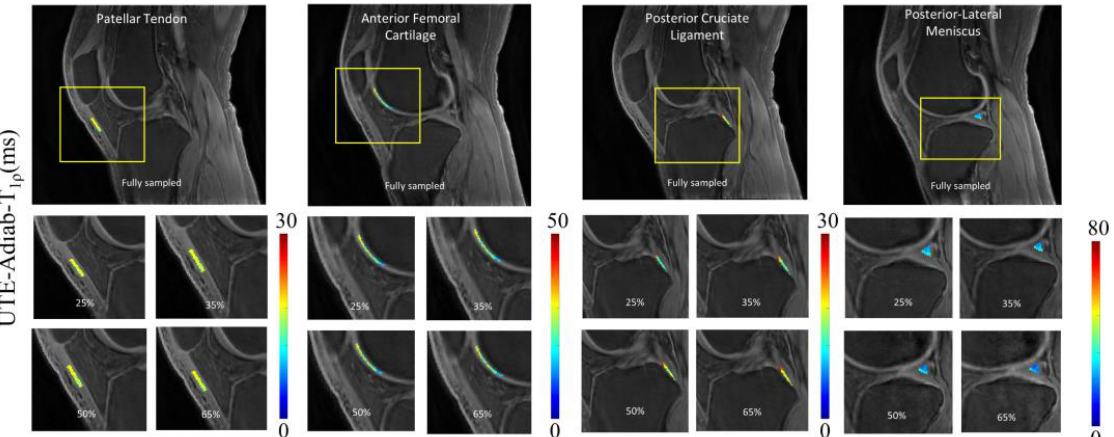
Figure 6. Quantitative mapping of UTE-Adiab-T 1 ρ parameter at different undersampling levels in four representative ROIs. The estimated T 1 ρ parameter ranged between 15 and 40 ms in the aforementioned ROIs.